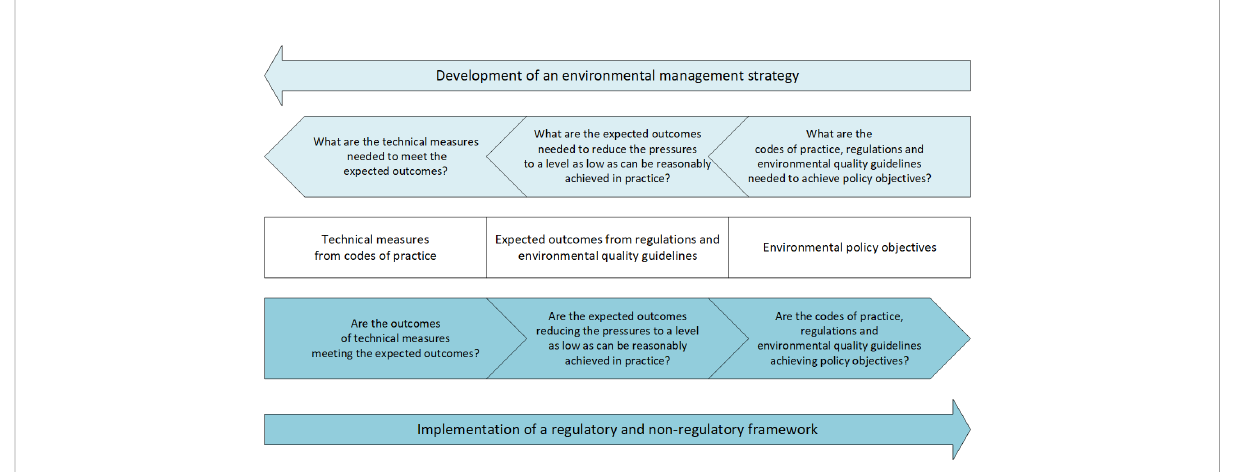
FIGURE 1 The difference between the questions for developing an environmental management strategy versus the implementation of regulatory and non-regulatory